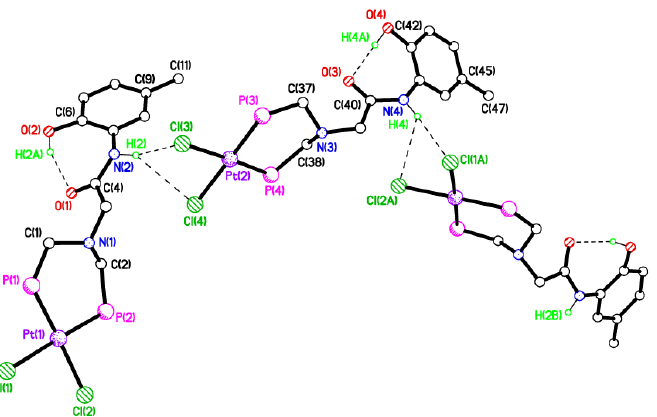
Figure 12. Packing motif in the crystal structure of 5a ∙ ½Et 2 O. Most H atoms, two Ph groups per P atom and the two, half-occupied, Et 2 O molecules have been omitted for clarity.